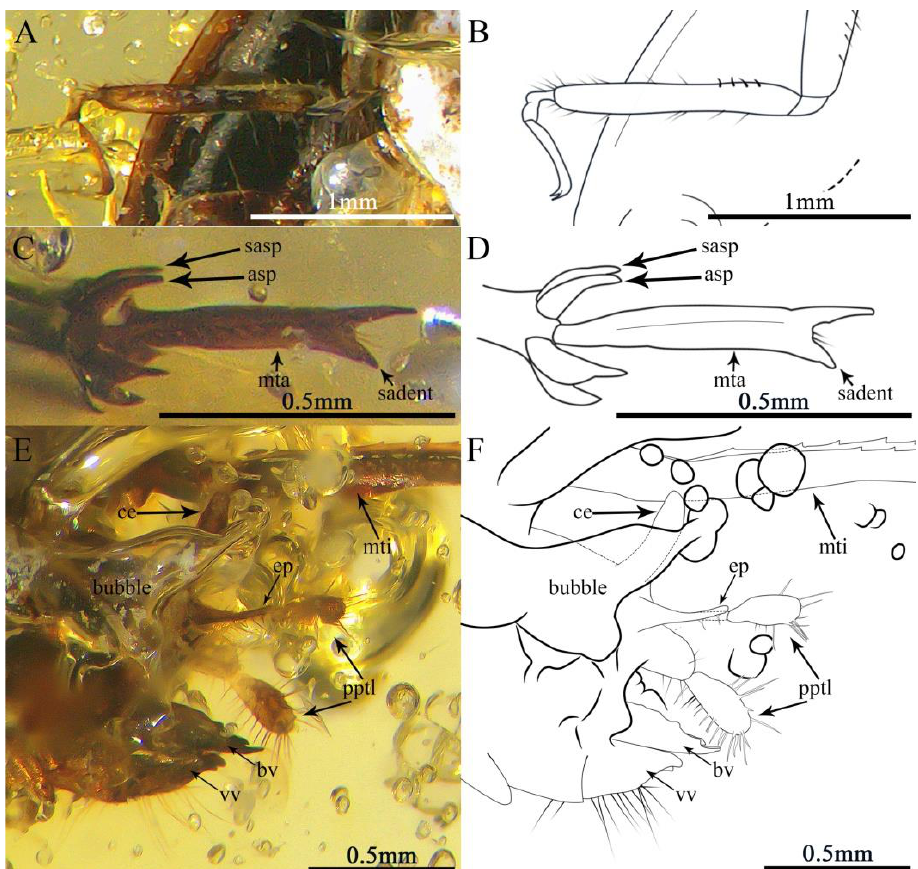
Figure 4. Details of Magnidactylusgracilis sp. nov.: ( A ) photograph of left mesotibia, ( B ) line drawing of left mesotibia, ( C ) photograph of right metatarsus, (photograph obtained by holding specimen SICAU – A – 085 upright with its side up), ( D ) line drawing of right metatarsus, ( E ) photograph of terminal abdominal and ( F ) line drawing of terminal abdominal. The legs: Prothoracic leg — prothoracic leg brown, markedly shorter than mesotho- racic leg; profemur squeezed out of shape, with long dorsal and ventral setae; protibia robust, slightly inflated distally with a dense covering of setae and four strong dactyls; protarsus two-segmented, slender, with second segment longer than first; basitarsus short; apical tarsomere elongate, slightly curved; pretarsus with two slender claws. valvewith a powerful side tooth at apex (Figure Mesothoracic leg — mesofemur dark brown, with light coloration near the middle and times as long as profemur, broader in the middle; mesotibia brown, with light colora-